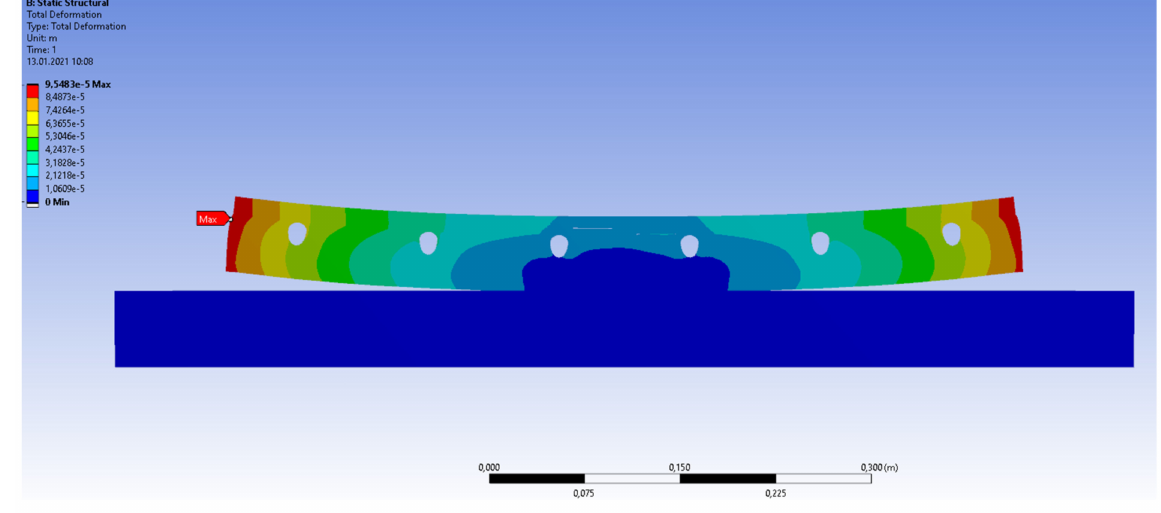
Figure 24. System deformation in the Ansys program.